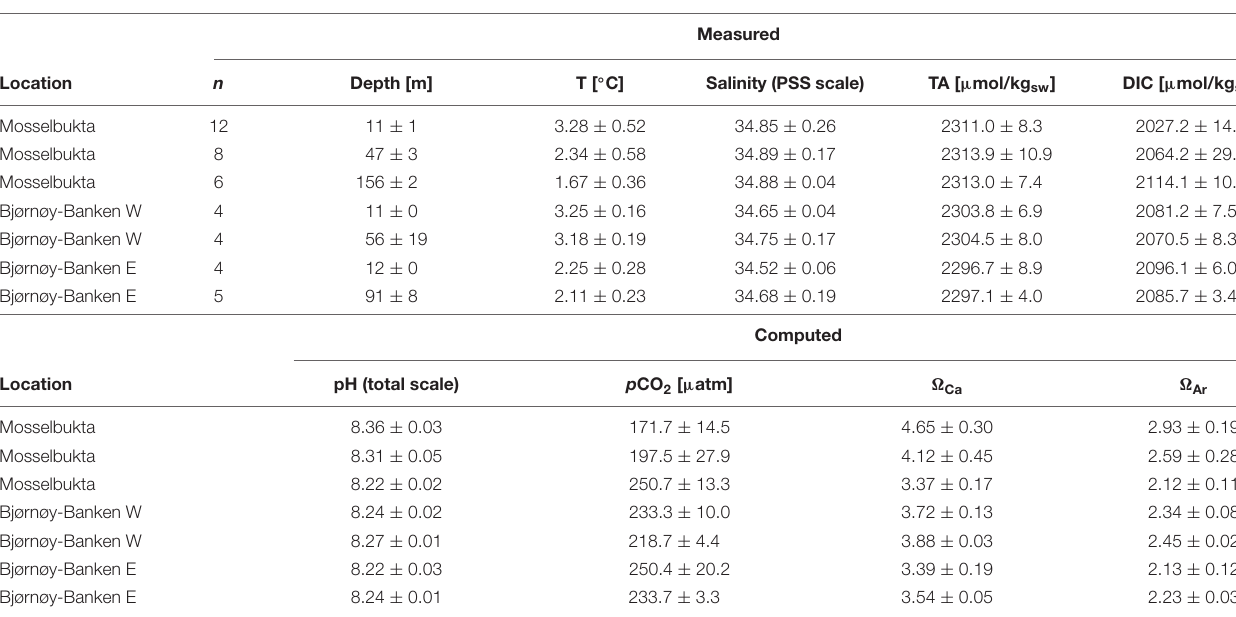
TABLE 3 | Measured and computed carbonate system parameters in Mosselbukta and at Bjørnøy-Banken (W and E of the Polar Front) for surface and bottom waters, averaged over the available CTD casts (bottom water stations complemented with water samples taken by JAGO; total number of considered samples per depth indicated in the second